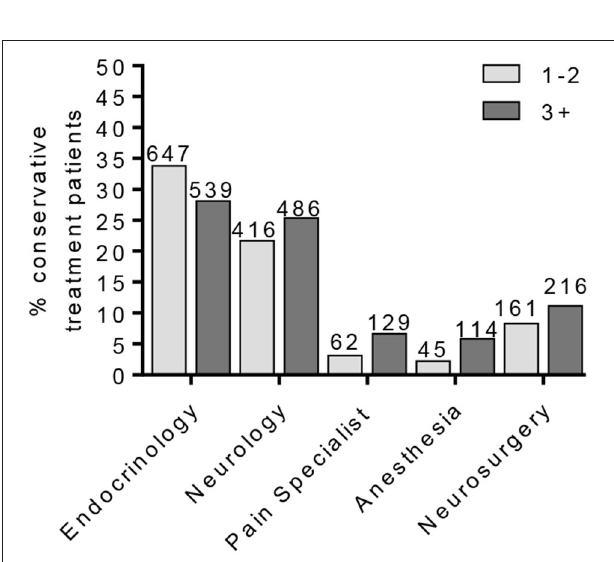
FIGURE 4 | Percentage of conservative treatment patients seen by providers. The percentage of PDN patients in the conservative treatment group according to patient provider visits. This cohort was further separated into patients on one–two or three or more pain